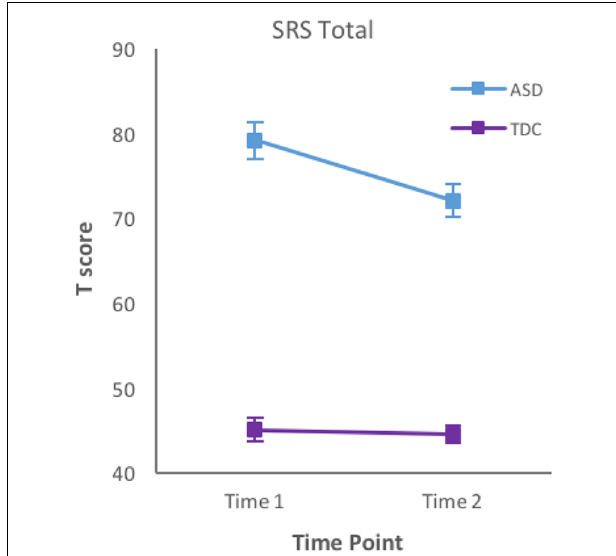
FIGURE 2 | Mean T scores and standard error bars of parent-reported SRS Total at time 1 and time 2. SRS, Social Responsiveness Scale; ASD, Autism Spectrum Disorder; TD, typically developing children.